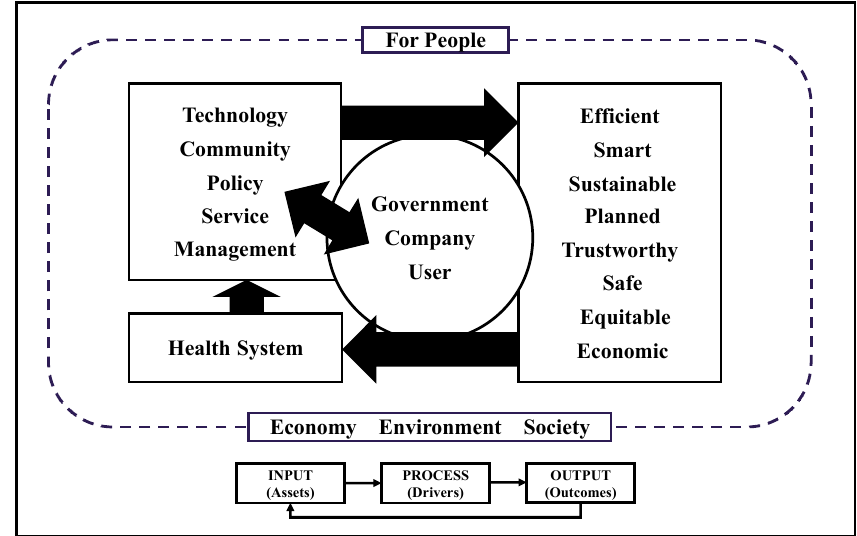
Figure 4. Smart Health Model.